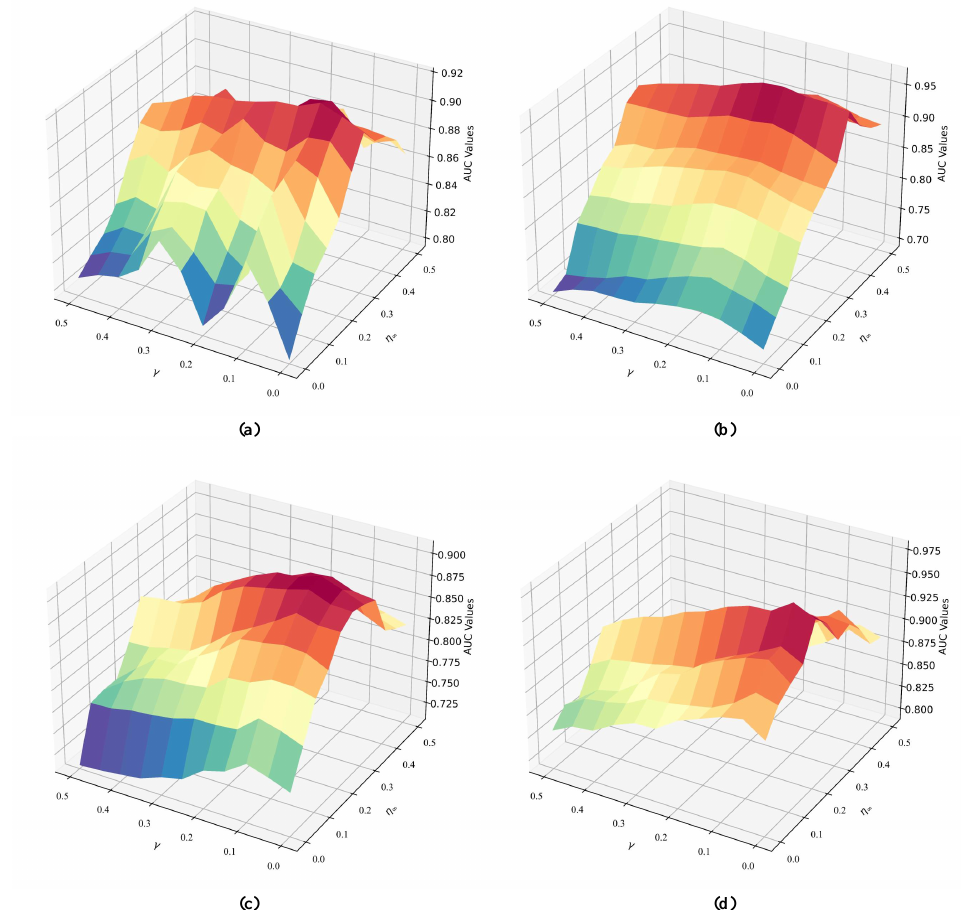
Figure 16. The 3D plots for AUC values of ( P D , P F ) of the different experiments on a ( a ) simulated water dataset, ( b ) sea water dataset, ( c ) river water dataset, and ( d ) lake water dataset.